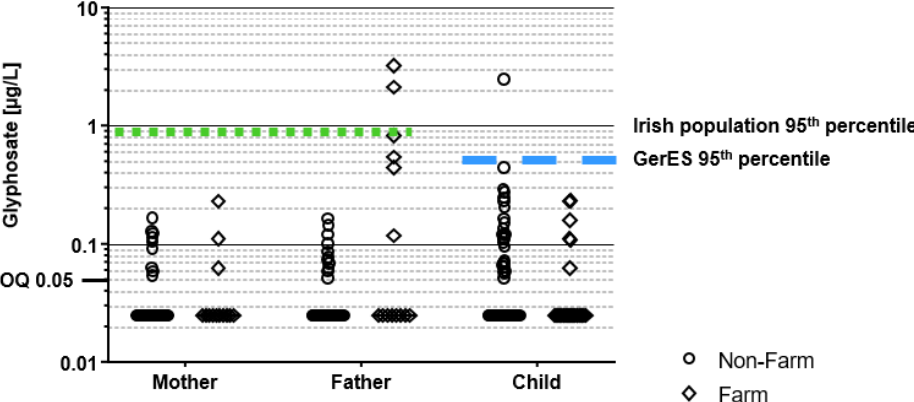
Figure 1. Urinary concentrations of glyphosate by the family member (e.g., mother, father, child) and family type (e.g., farm and non-farm). Comparisons made with the 95th percentile of HBM study of the Irish adult population [57] represented by green dots and the 95th percentile of a German children population from the GerES study [31], represented by a blue dash.